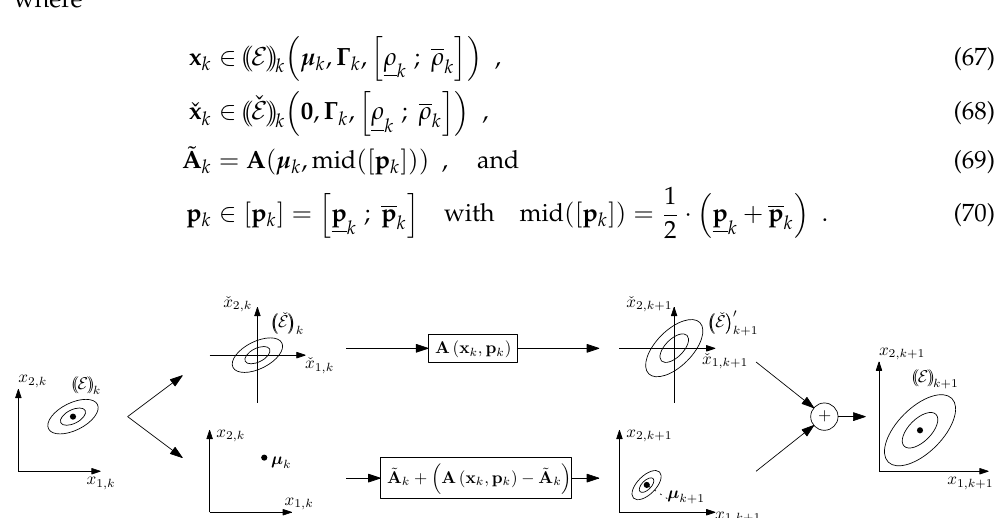
Figure 7. Separation of the state equations according to (66)–(70) into the mapping of an origin- centered ellipsoid and the verified treatment of non-zero offset